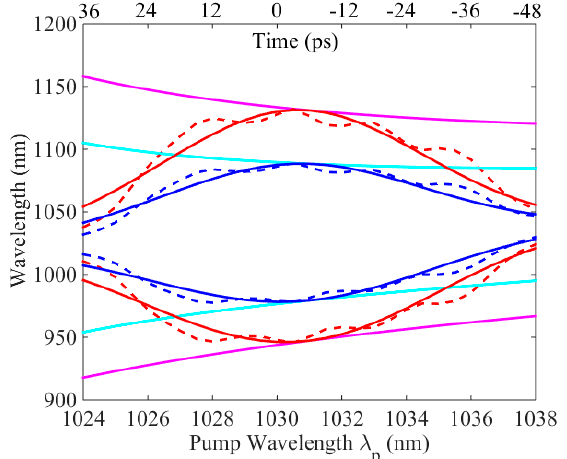
Figure 2. Phase matching as a function of the pump wavelength for a chirped pulse with a Gaussian spectrum (solid red and blue lines) or with the experimental profile (dashed red and blue lines). The maximum power was 600 W (red lines) or 200 W (blue lines). The magenta and cyan lines correspond to the phase matching for a constant peak power of 600 W or 200 W,